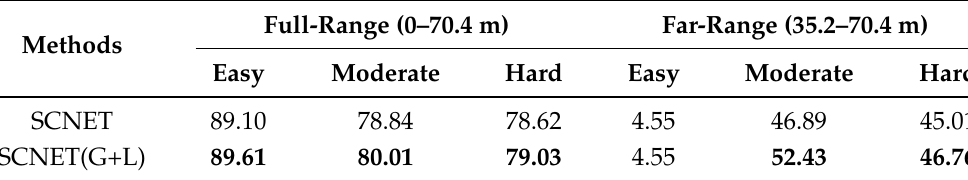
Table 4. Bird’s eye view (BEV) detection performance on adaptation from 64-channel data to 32- channel data.